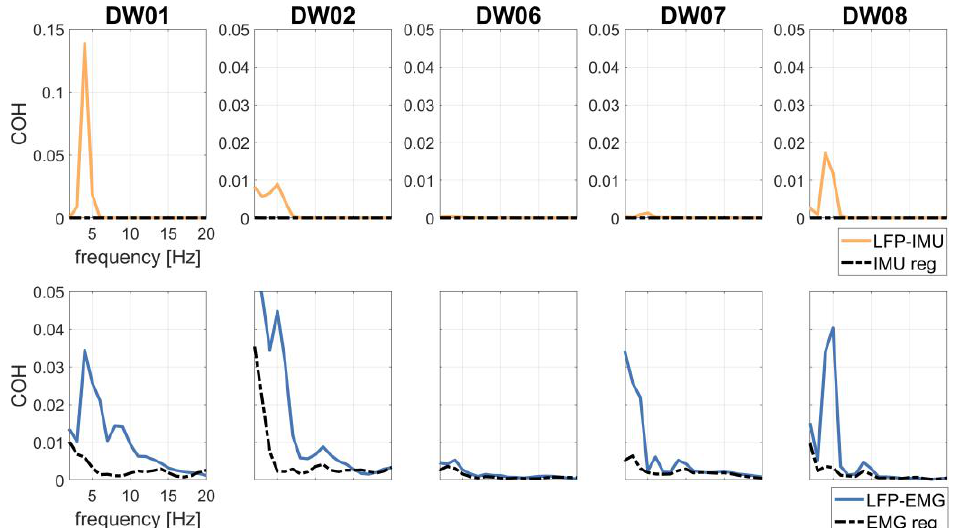
Figure 4. LFP – IMU COH (first row) without (continuous, yellow line) and with (dotted, black line) IMU regression in patients T+. LFP – EMG COH (second row) without (continuous, blue line) and with (dotted, black line) EMG regression in patients T+.